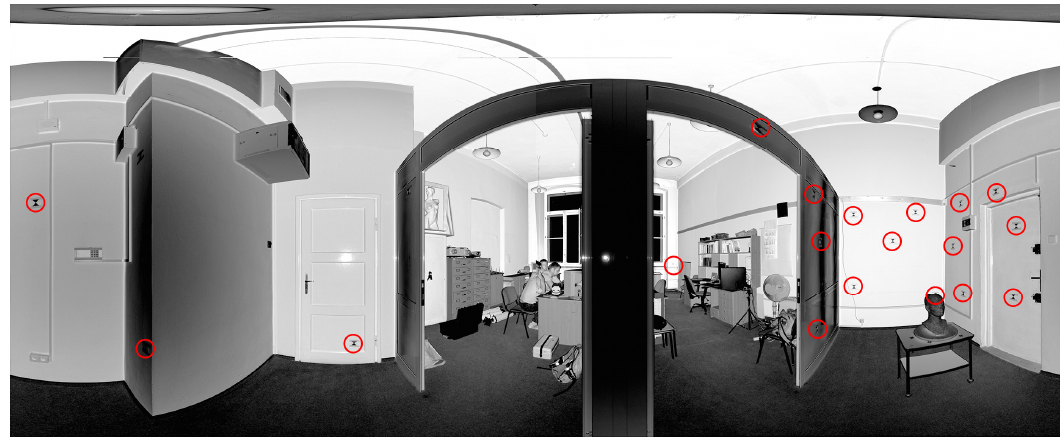
Figure 7. The example of the point cloud in the spherical projection of test site III: “The office room” with marked check points (red circles).